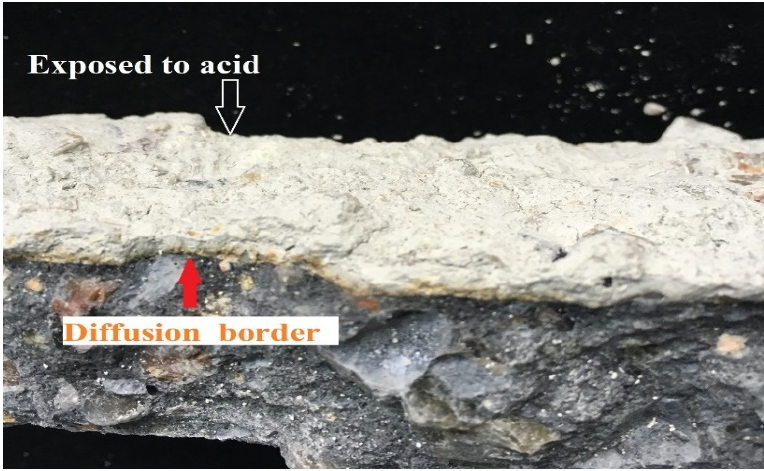
Figure 11. The effects of H 2 SO 4 exposure on the texture and color of the concrete matrix.